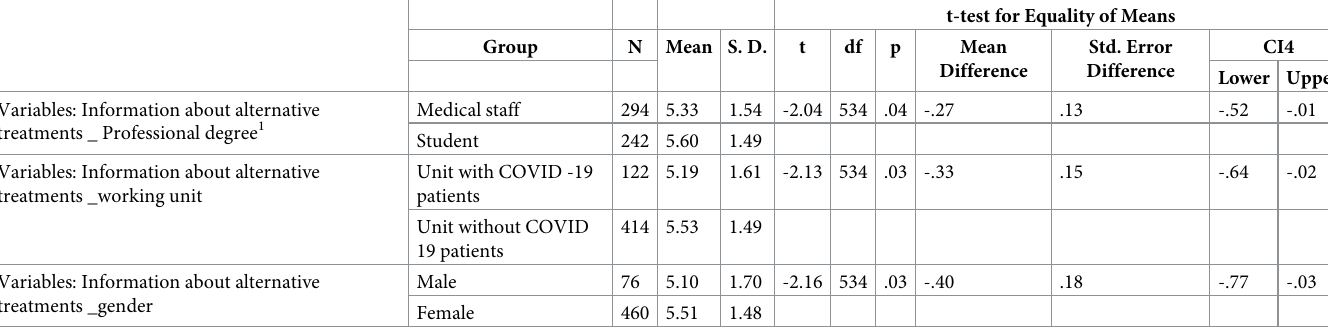
Table 4. Significant t-test results: Comparisons between